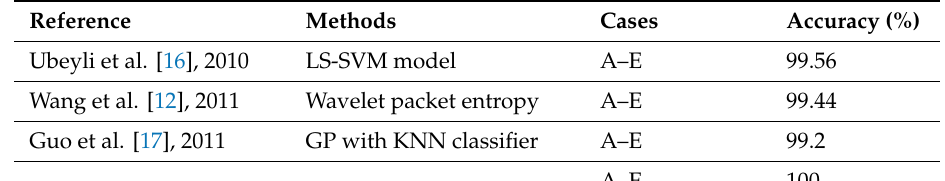
Table 4. Comparison of performance (in terms of classification accuracy) of the proposed method with recently developed algorithms for seizure classification. LS, least square; GP, genetic programming; KNN, k -nearest numbers; ICFS, improved correlation-based feature selection; SODP, second-order di ff erence plot; EMD, empirical mode